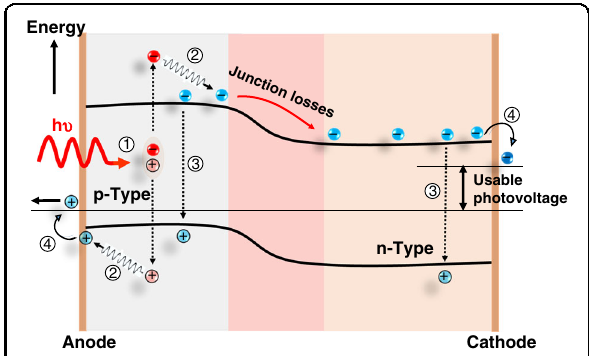
Fig. 1 Pathways of primary energy loss in a conventional single- junction solar cell: (1) photoexcitation (2) hot charge carrier loss, (3) recombination losses, and (4) contact losses. The fi gure is taken from ref. 32 and modi fi